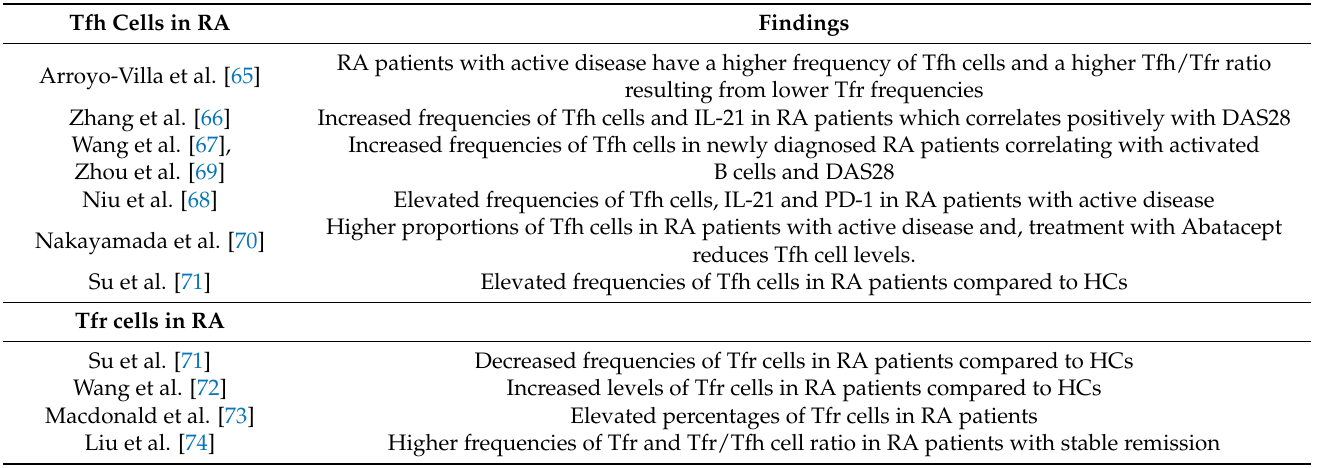
Table 1. Summary of studies involving aberrant Tfh and Tfr cells in human